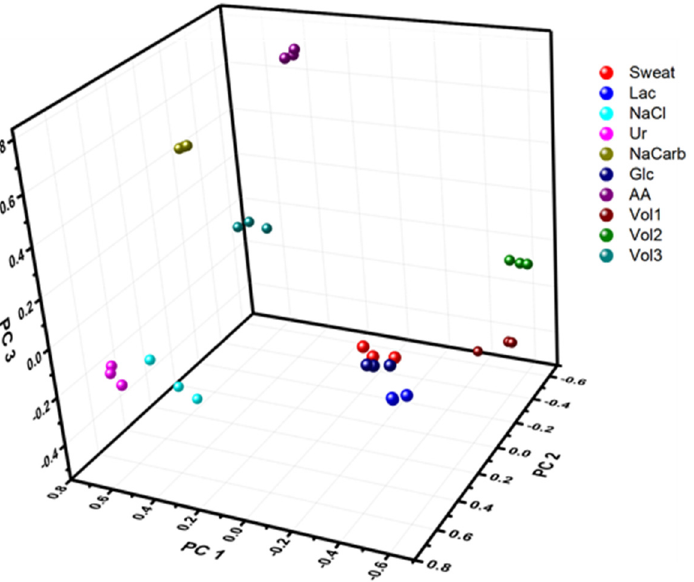
Figure 3. PCA score plot of three different repeat measurements using a micro e-tongue (Device 2) in sweat samples collected from three different volunteers (Vol 1, Vol 2, Vol 3) and sweat spiked with different metabolites; 5 mM glucose (Glc), 10 mM lactate (Lac), 100 µg mL − 1 ascorbic acid (AA), 10 mg mL − 1 albumin (Alb), 150 mM sodium chloride, 10 mM urea (Ur) or 100 mM sodium bicarbonate (NaCarb). Explained variance of PC 1 (34.4%), PC 2 (24.5%), and PC 3 (18.9%).